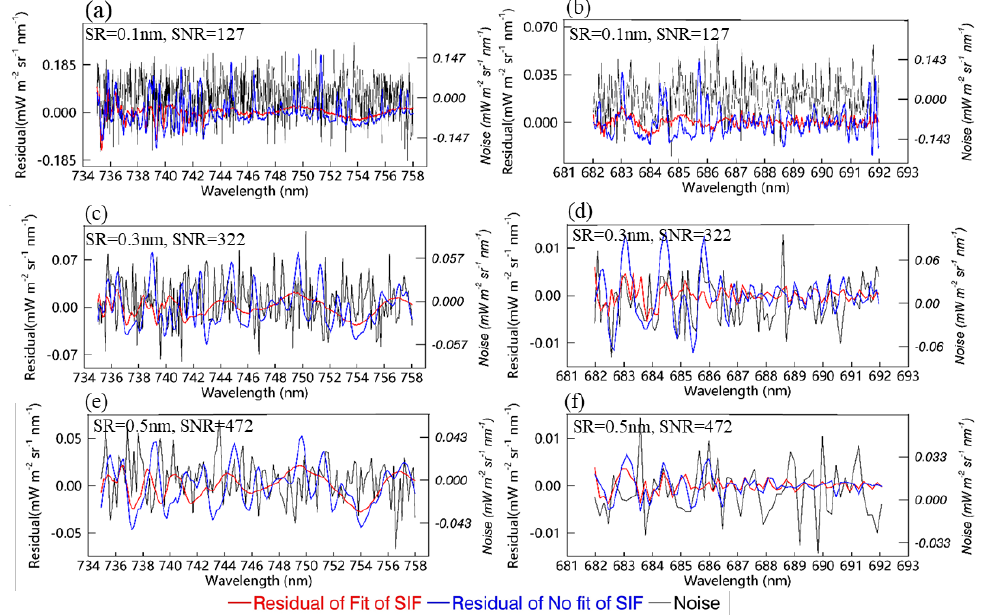
Figure 8. The spectral residuals between the fitted and measured TOA radiances when the retrieved SIF is fitted (blue) and not fitted (red), as well as the noise spectrum (black). ( a , c , e ) are the spectral residuals for the far-red band with an SR of 0.1 nm and SNR of 127, an SR of 0.3 nm and SNR of 322, and an SR of 0.5 nm and SNR of 472, respectively; ( b , d , f ) are those for the red band, respectively.